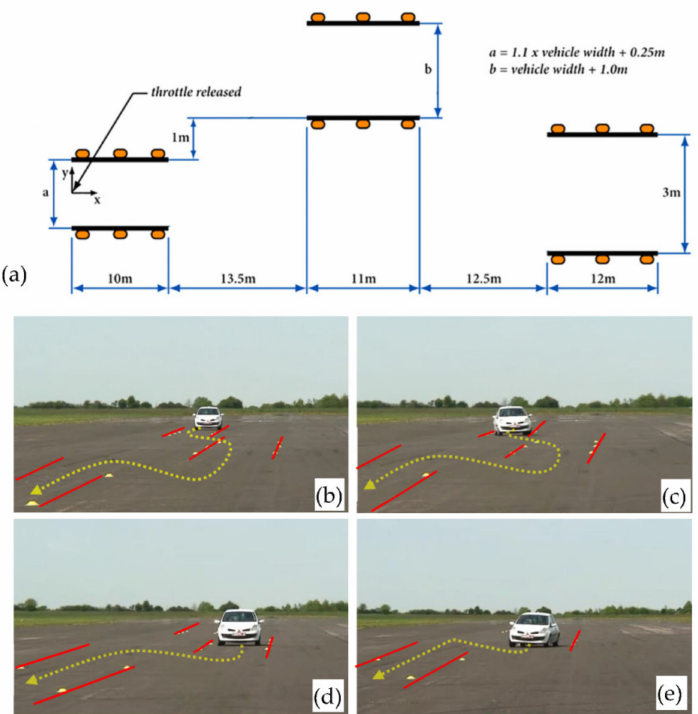
Figure 22. ISO 3888-2 lane-change maneuver with the lane widths depending on the vehicle width ( a ); sequential shots ( b – e ) of a vehicle performing test ruled by the above standard configuration, defined on the track by the stake-out